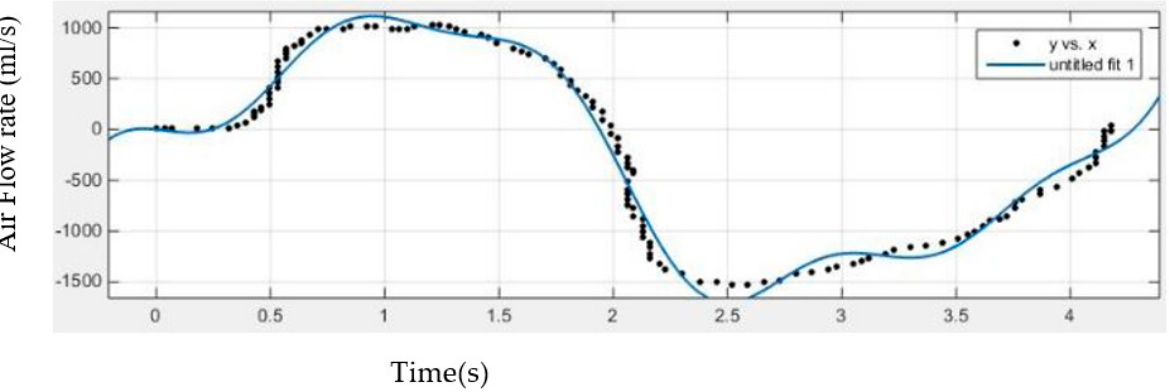
Figure 4. Inhalation and exhalation flow rate during smoking; [Pattern taken from British American Tobacco (www.bat.com (accessed on 24 June